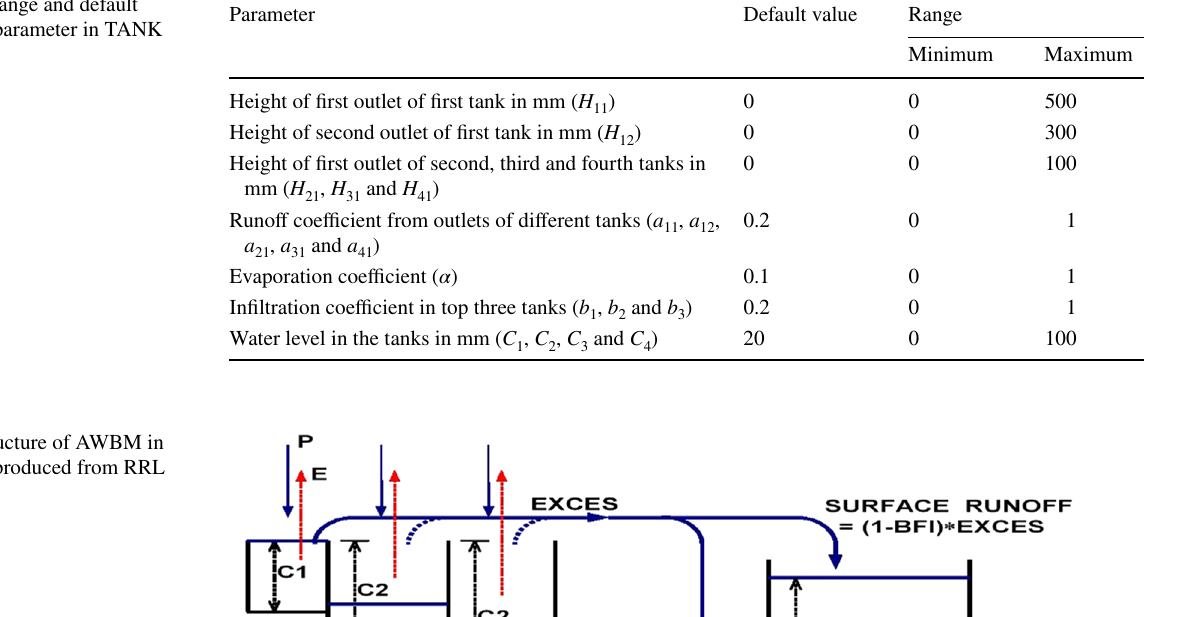
Table 2 Range and default values of parameter in TANK model